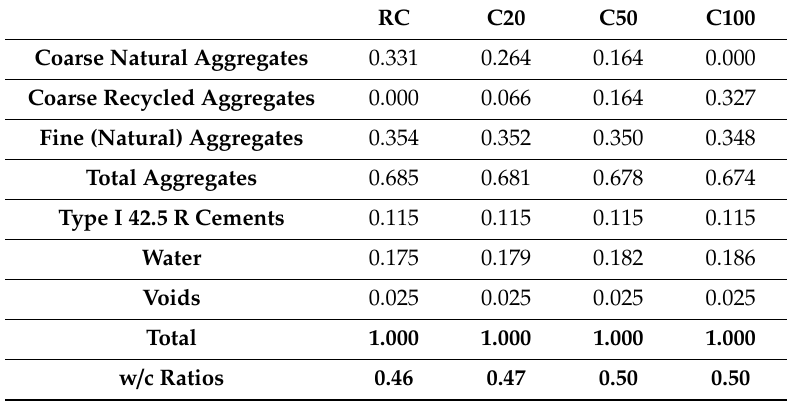
Table 3. Composition of the concrete mixes studied (m 3 / m 3 ) and estimated w / c ratios.